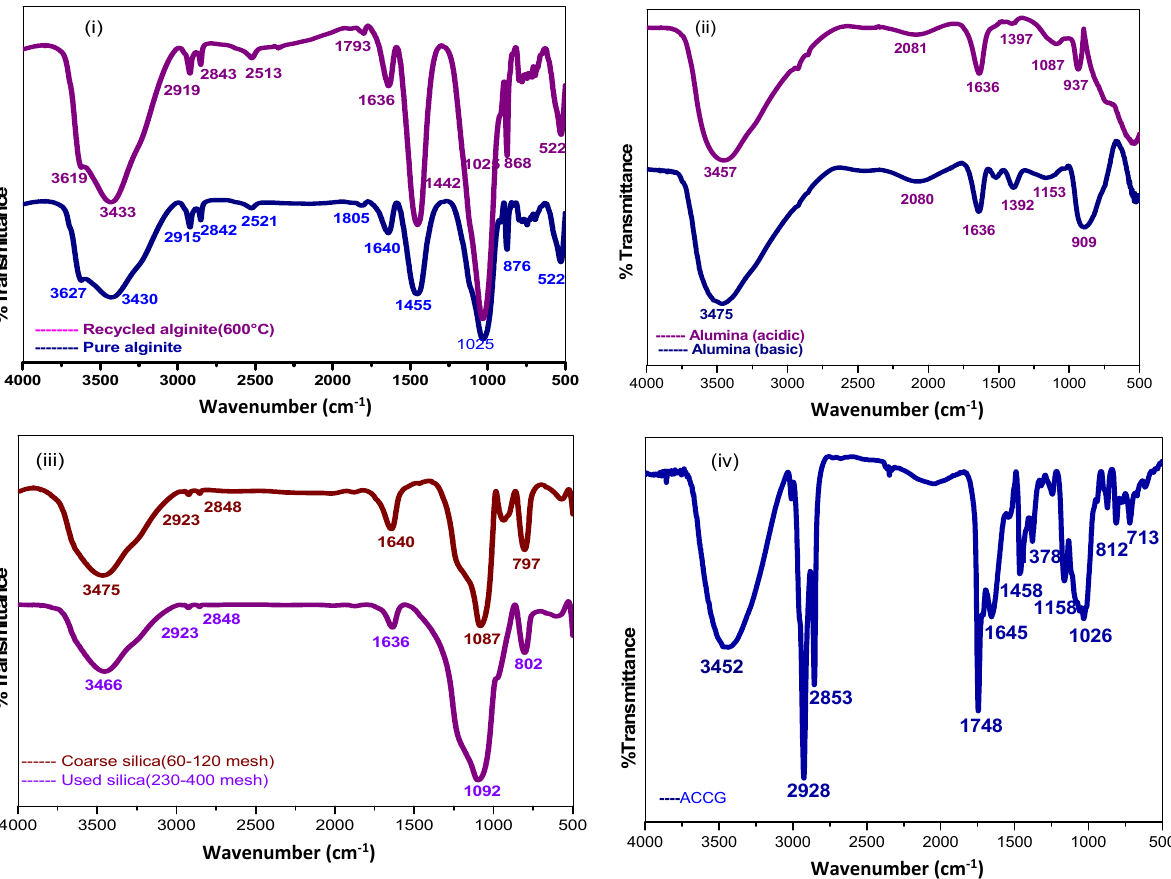
Figure 4. FT-IR spectra of ( i ) alginite before adsorption and after the first-time regeneration at 600 °C. ( ii ) Alumina (acidic and basic). ( iii ) Coarse and used silica gel. ( iv ) Activated coffee grounds (ACCG). In the FT-IR spectral data for acidic alumina and basic alumina before the